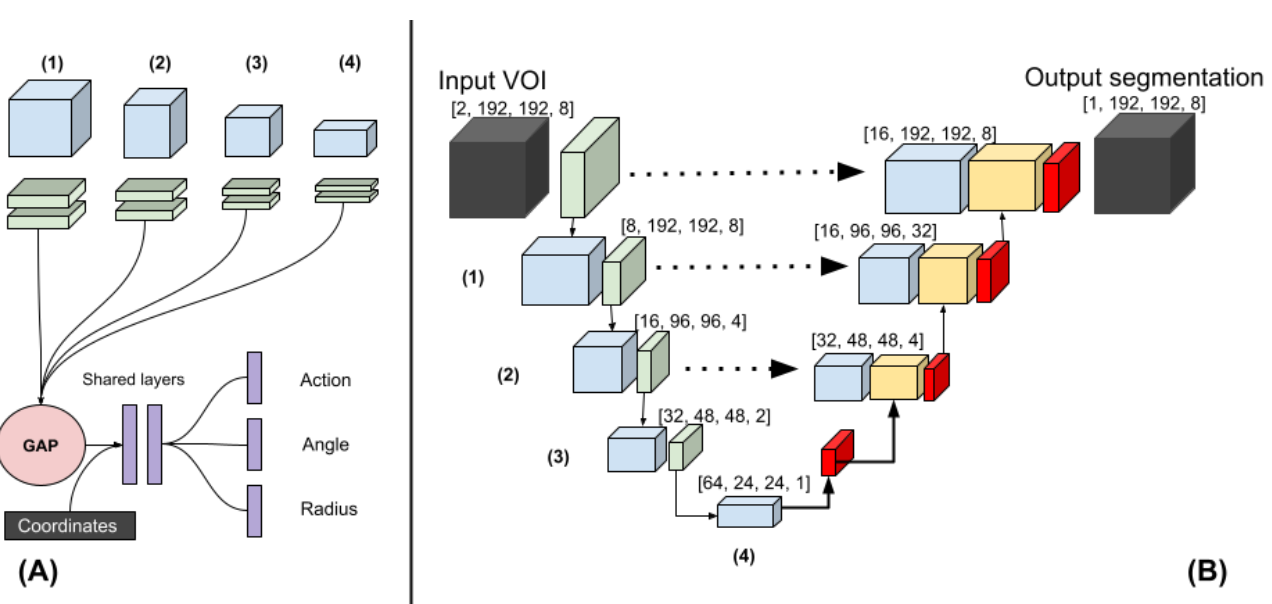
Figure 1. ( A ) The polar-UNet is created by attaching the following operations to the BL-UNet. The features from four levels in the down-sampling path are input to four blocks consisting of two convolutions. The output is global average-pooled and concatenated before being passed to the fully connected shared layers. Finally, individual fully connected layers are used to classify the action and regress the angle and the radius. ( B ) Three-dimensional Baseline UNet (BL-UNet). Three-dimensional ResNet blocks followed by a max-pooling operation (green) were used to construct the down-sampling path (left). Three-dimensional ResNet blocks followed by a transposed convolution were used to construct the up-sampling path (right). The features generated in the down- and up-sampling paths are blue and yellow, respectively. Skip connections were added between the up-sampling and down-sampling paths.